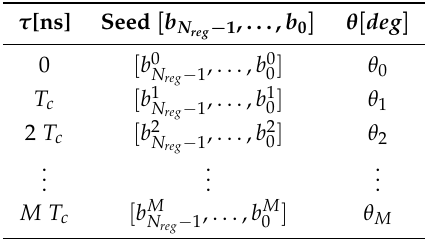
Table 1. LFSR LUT used to fully reproduce the sequence starting from a specific delay. In this notation M = 2 N reg − 1 represents the sequence period, while the shifts are performed over multiples of the chip width, T c . The seed consists of a digital word of N reg bits, [ b N